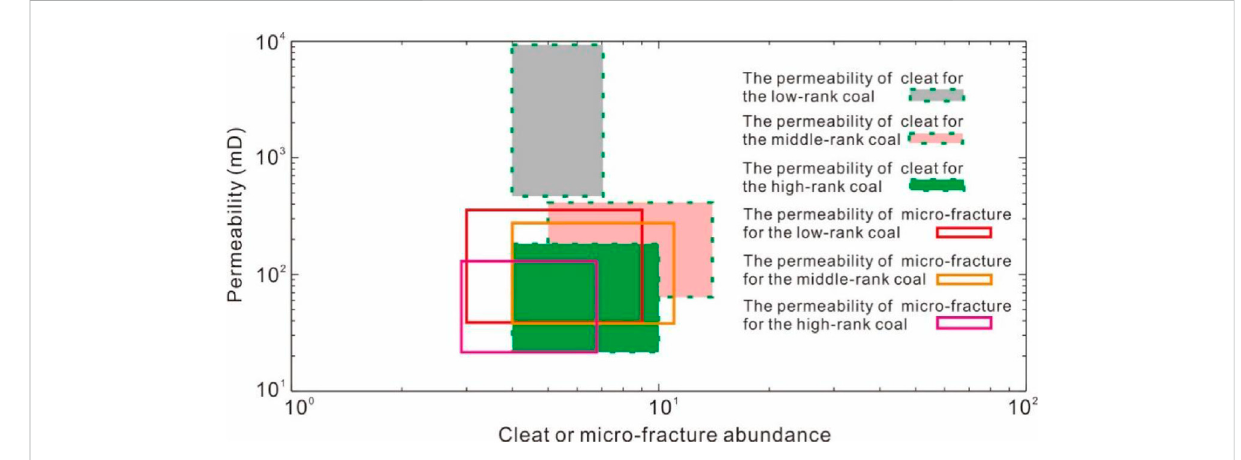
FIGURE 12 Permeability of cleat and micro-fracture for the coals of different ranks based on Weniger et al.